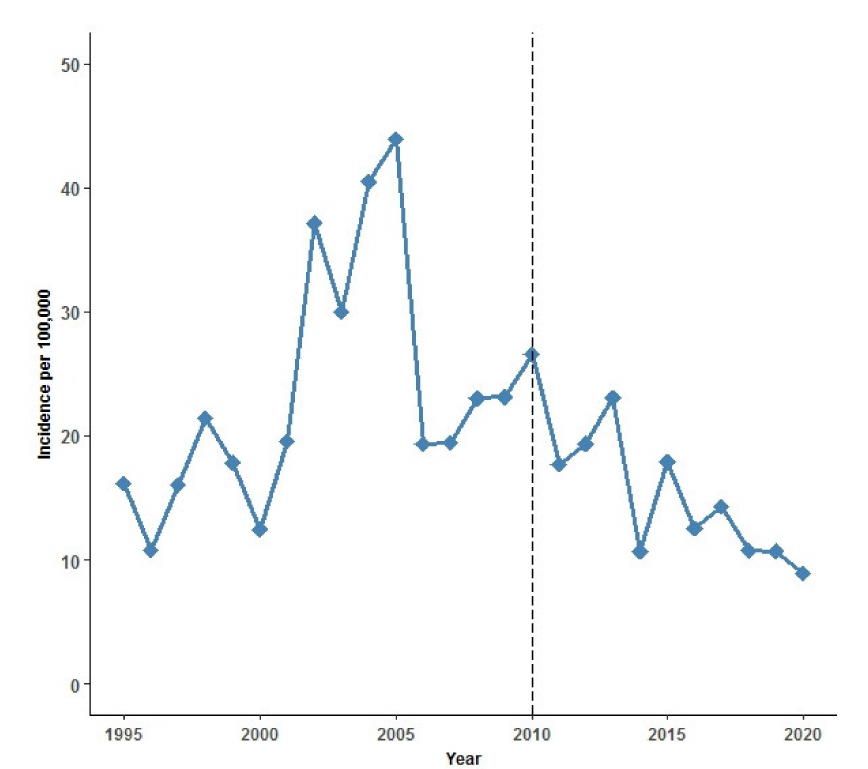
Figure 1. Annual incidence rate of invasive pneumococcal disease (IPD) per 100,000 person years 1995–2020 in Greenland. Black dashed line indicates introduction of the 13-valent pneumococcal con- jugate vaccine (PCV13) to the childhood vaccination program (CVP) in Greenland in September 2010.